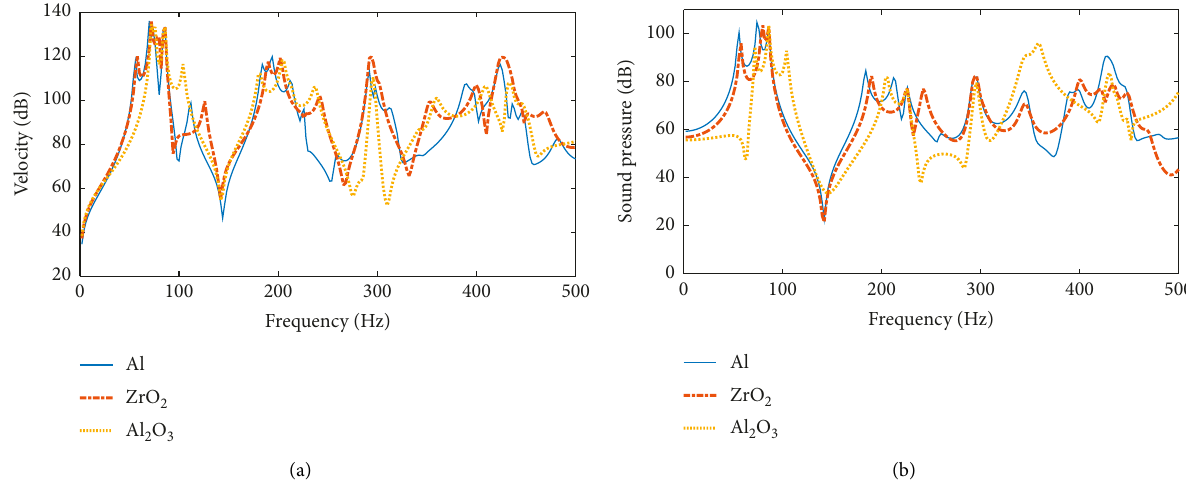
Figure 14: Vibration velocity response at the point on the surface of panel 2 and sound pressure response at the point in the acoustic cavity a with different material of the stiffener: (a) vibration velocity response and (b) sound pressure response.